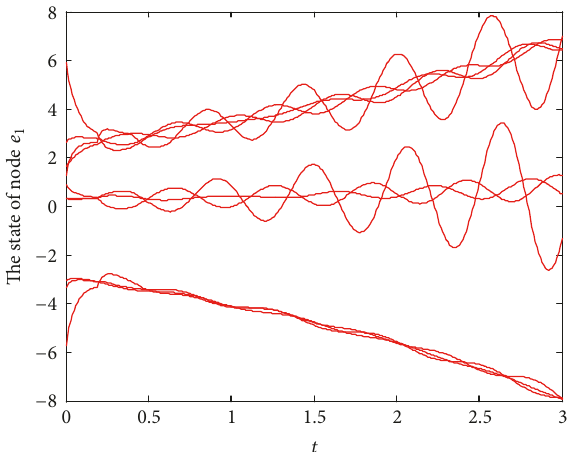
Figure 2: Synchronization error 𝑒 𝑖1 that does not satisfy the